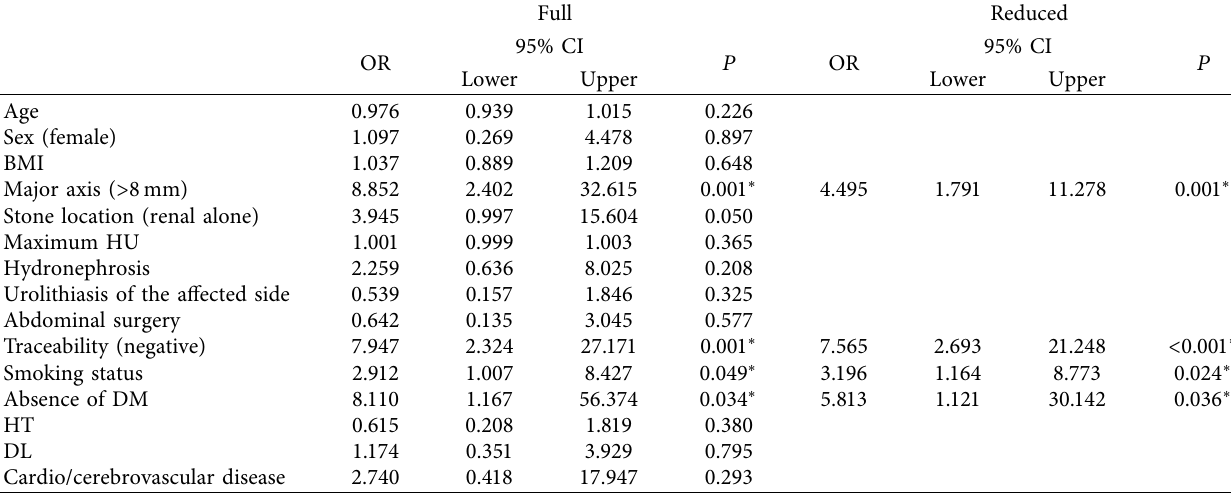
Table 2: Multivariate logistic regression